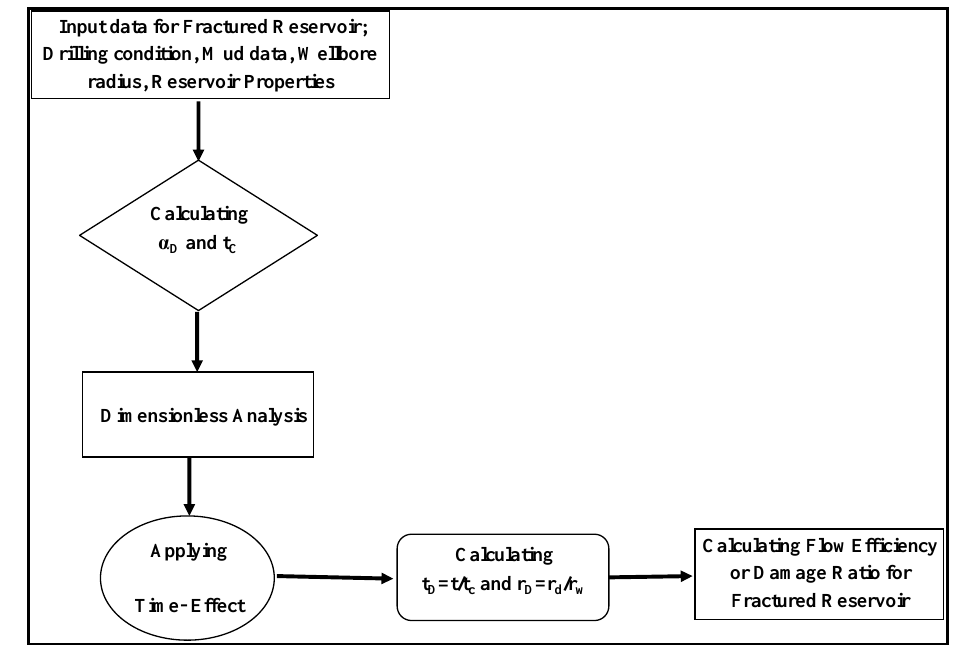
Figure 3. Flow diagram for FEUBD, the effect of time and short overbalanced pressure during